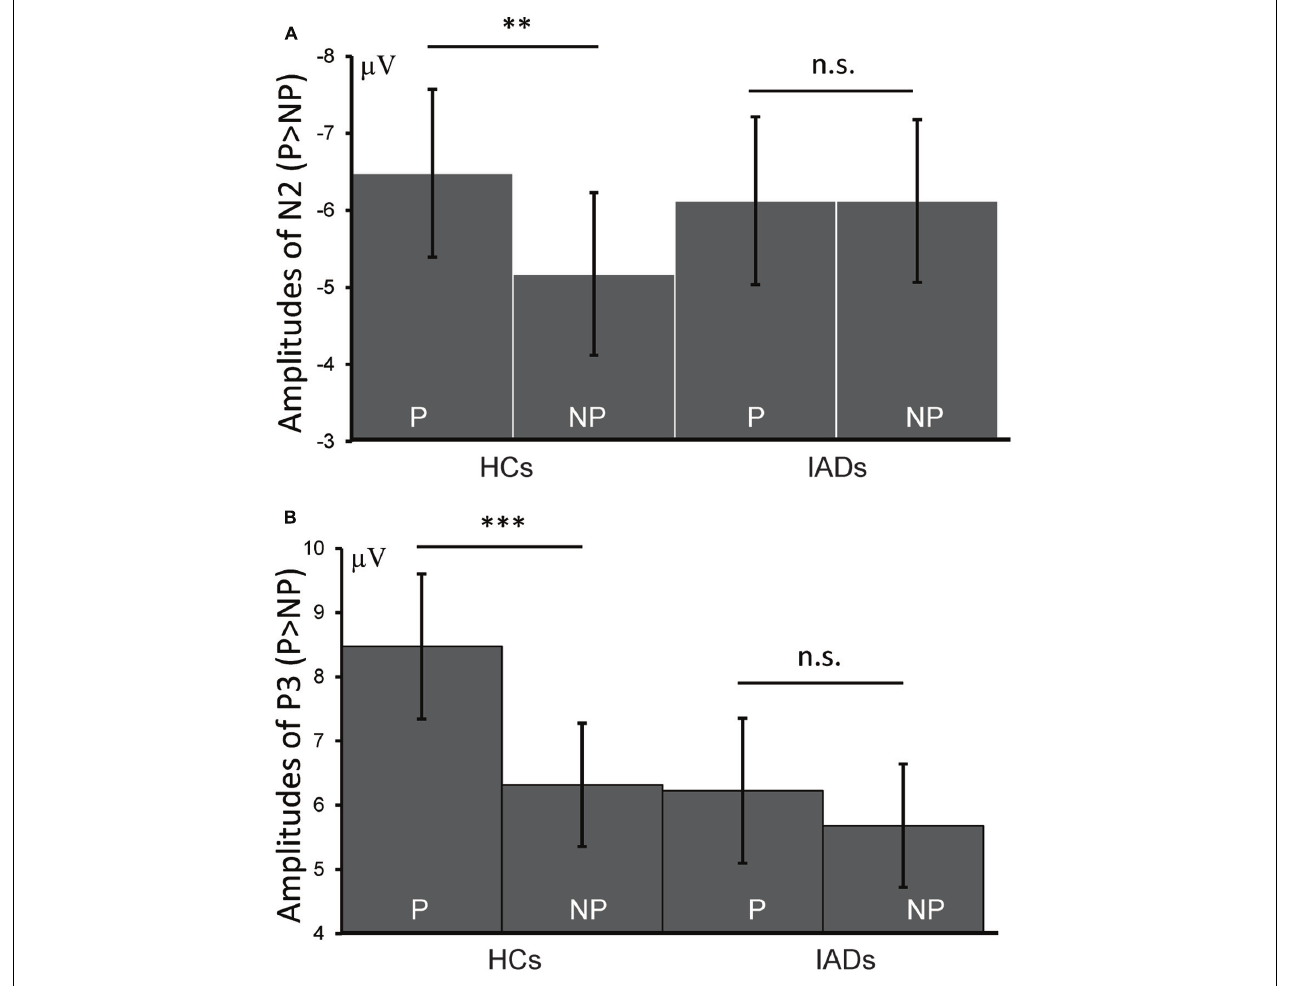
FIGURE 5 | Correlation between amplitudes of N2 (painful > non-painful) and PD scores.